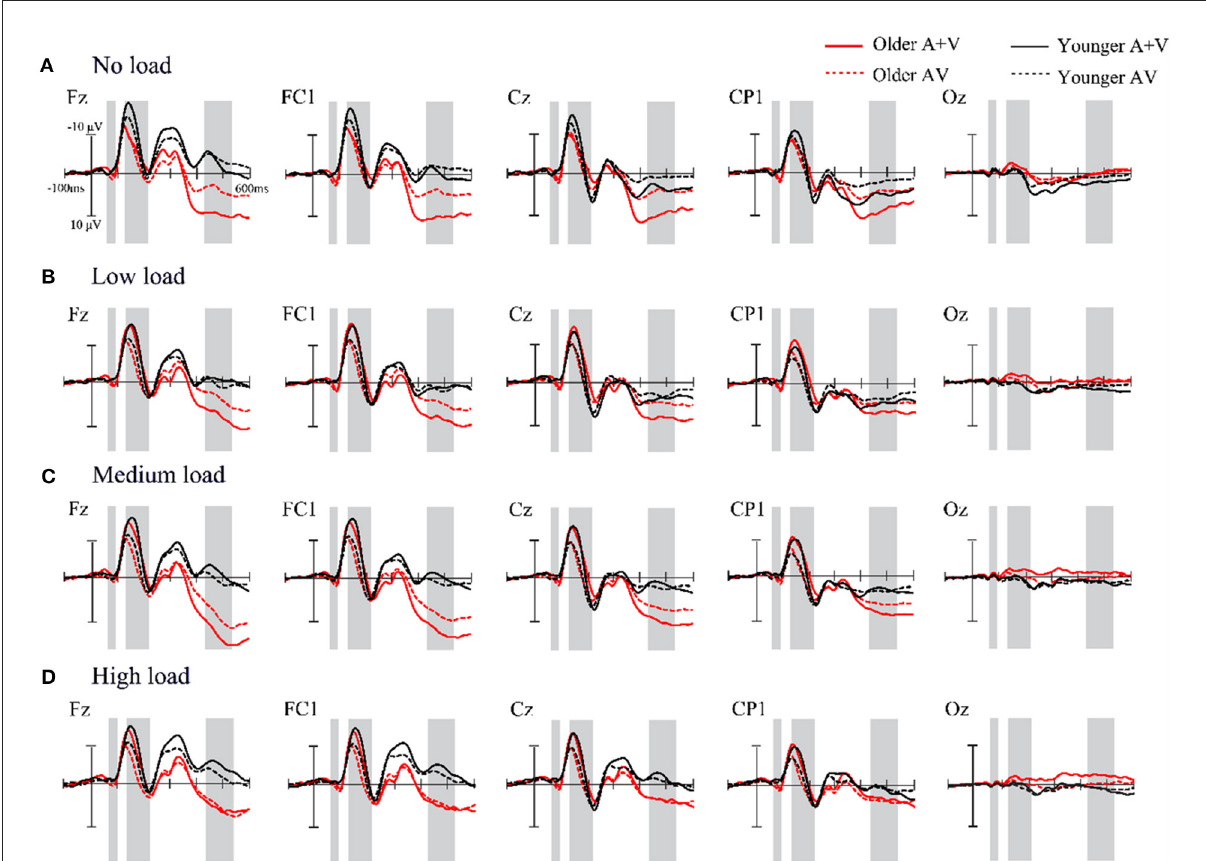
FIGURE3 (A–D) Comparison of the sum of the event-related potentials of the unimodal stimuli (A + V) and the event-related potentials of the bimodal stimuli (AV) for a time interval of 0–600ms in the representative electrodes under the different load conditions. Shaded areas mark time intervals where a significant difference is